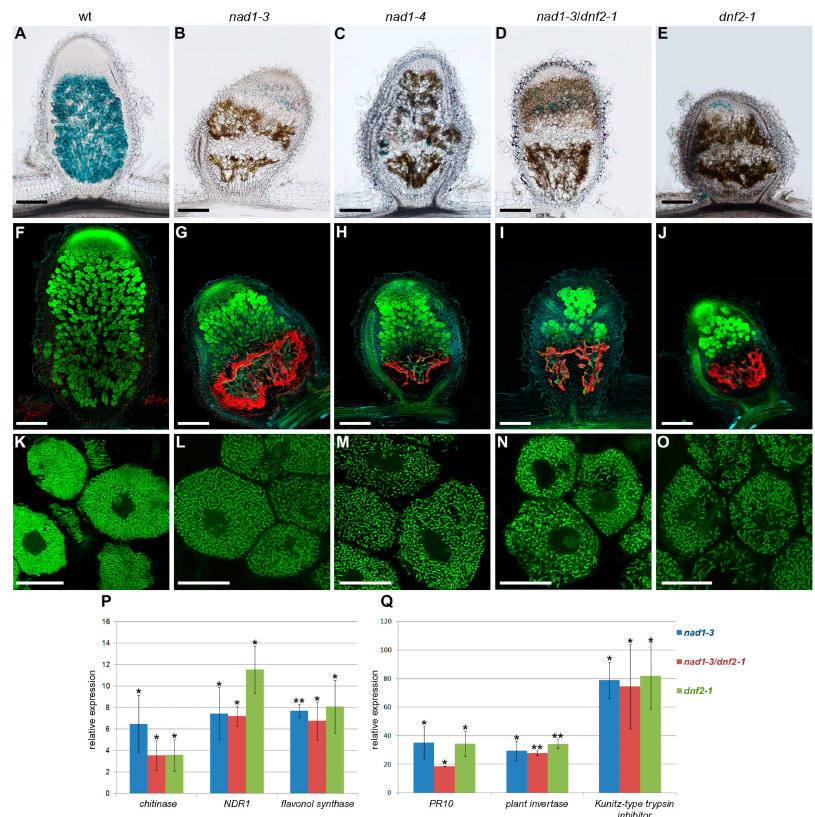
Figure 1. Induction of defense responses in nodules with activated defense 1 ( nad1 ), defective in nitrogen fixation 2 ( dnf2 ) and nad1/dnf2 mutant nodules. The degree of rhizobial infection, bacteroid differentiation and the presence of brown pigmentation showing autofluoescence in symbiotically ineffective Medicago truncatula mutants supposed to be deficient in suppression of plant defense responses during the symbiotic interaction. Nodules were harvested 14 days post-inoculation (dpi) with Sinorhizobium medicae WSM419 expressing the lacZ marker gene. Nodule sections were stained for β -galactosidase activity ( A – E ) or stained with SYTO13 ( F – O ) and analyzed by light or confocal microscopy, respectively. Wild-type nodules showed the characteristic zonation of indeterminate nodules ( A , F ). Nodules of nad1-3 ( B , G ), nad1-4 ( C , H ), nad1-3/dnf2 ( D , I ), and dnf2 ( E , J ) displayed extensive brown pigmentation that corresponded to the area showing autofluorescence which is pseudocolored in red. Higher magnification revealed elongated bacteroids in the infected cells of